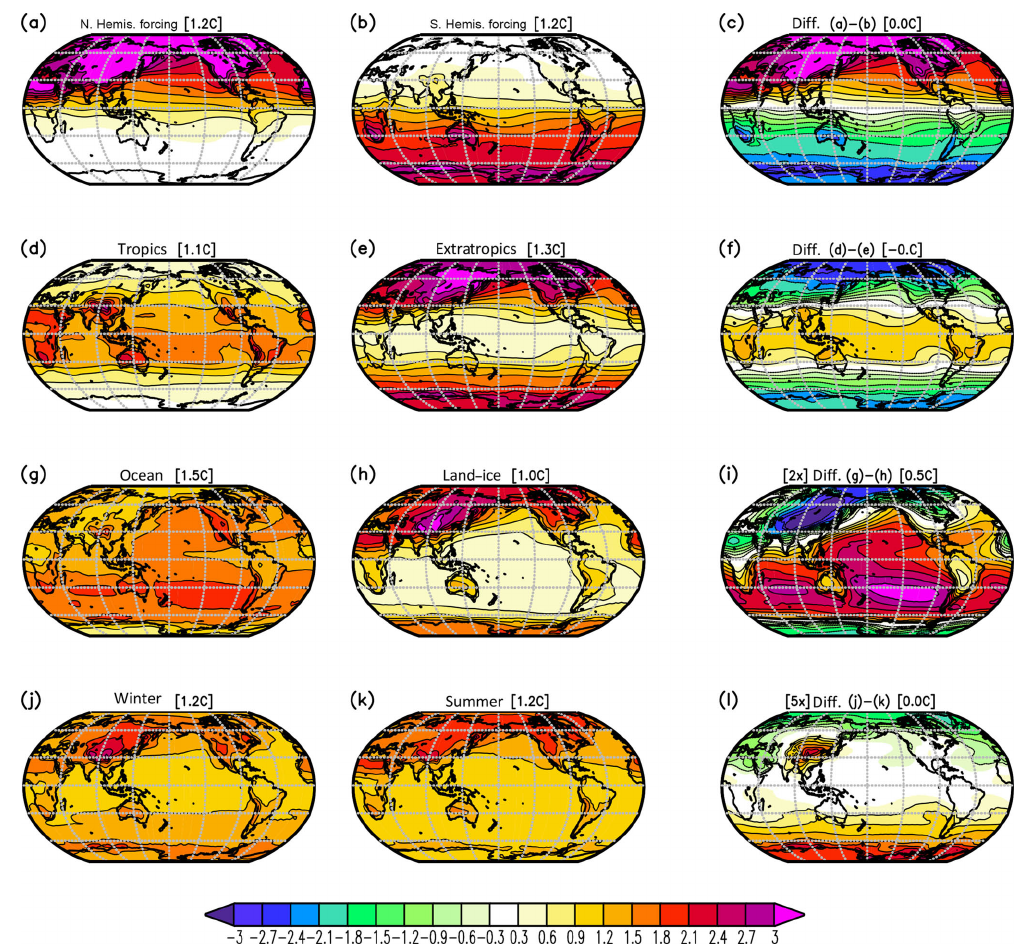
Figure 12. T surf response to partial doubling of the CO 2 concentration in the Northern (a) and Southern (b) Hemisphere, the tropics (d) , extratropics (e) , oceans (g) , land (h) , boreal winter (j) , and summer (k) . The right column shows the difference between the two panels to the left in the same